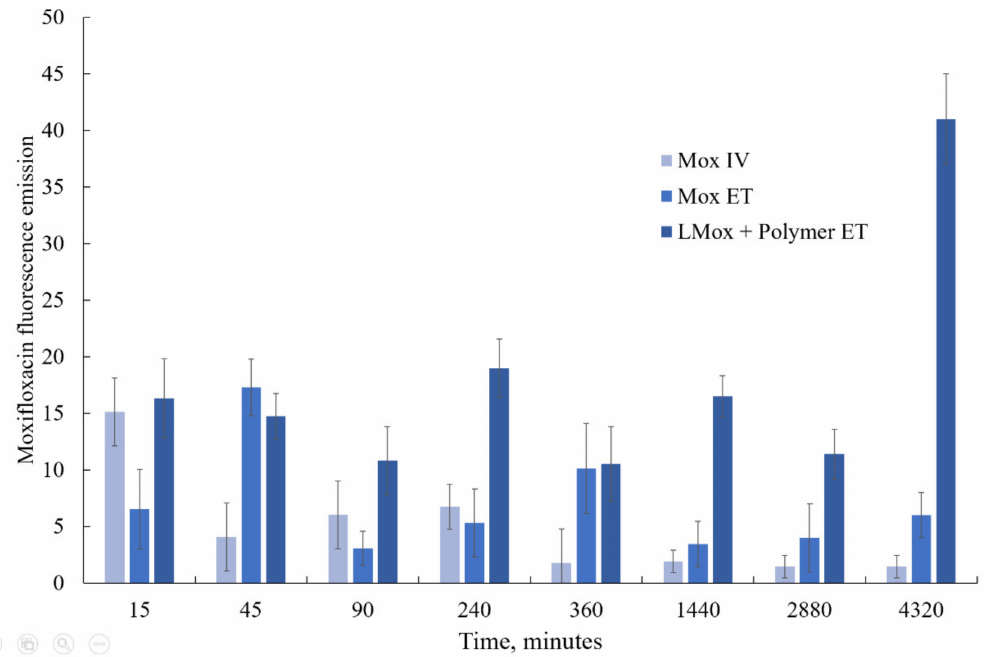
Figure 10. Accumulation of moxifloxacin in the lungs of mice after intravenous (IV) and endotracheal (ET) administration according to the fluorescence emission data. SD ( n = 3), p <